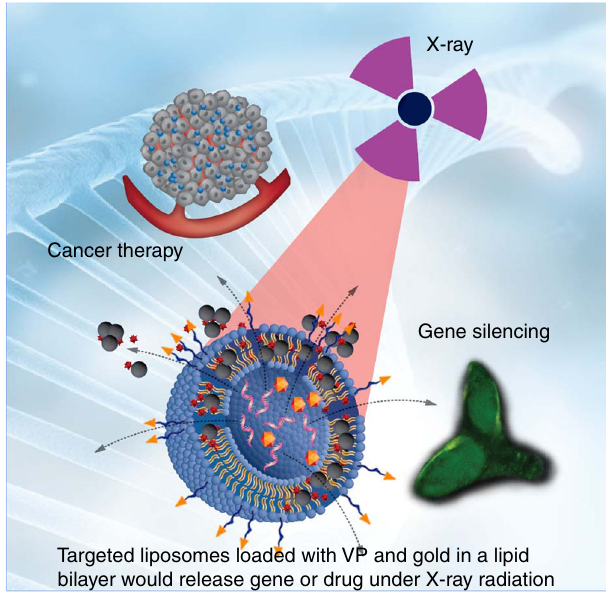
Fig. 1 The schematic illustration of gene silencing and cancer cell-killing by X-ray-triggered liposomes. This liposomal delivery platform incorporates vertepor fi n (VP) and gold nanoparticles. Two types of cargos, antisense oligonucleotide and Doxorubicin, are respectively entrapped inside a liposomal middle cavity for demonstration of in vitro gene release and in vivo drug